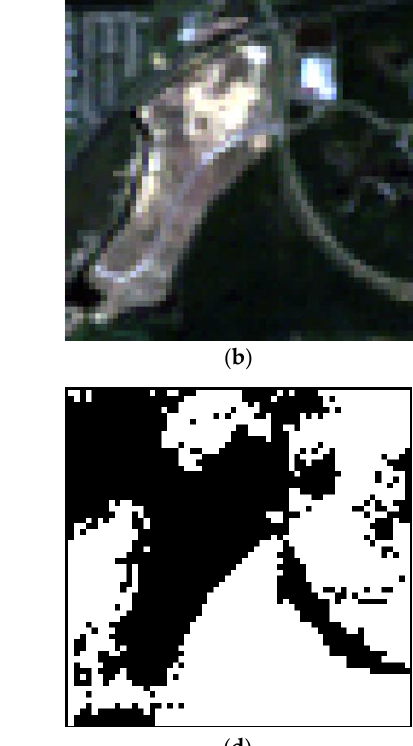
Figure 12. Comparison of the detection results for GF-1 imagery: ( a ) original image in 2015; ( b ) original image in 2017; ( c ) without stacking analysis; ( d ) with stacking analysis.